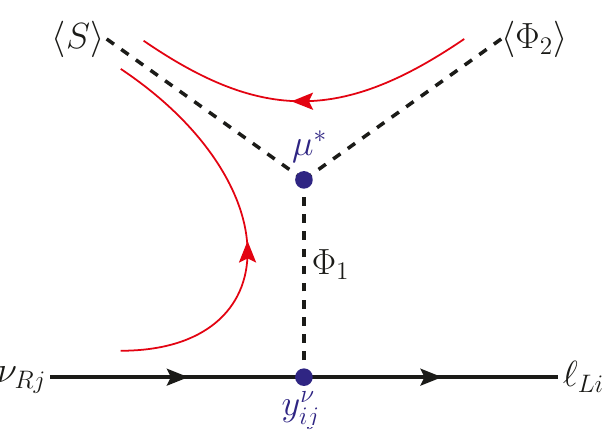
Figure 1 . Feynman diagram for the neutrino mass generation. The red (black) arrows represent the flow of U(1) PQ (lepton number)